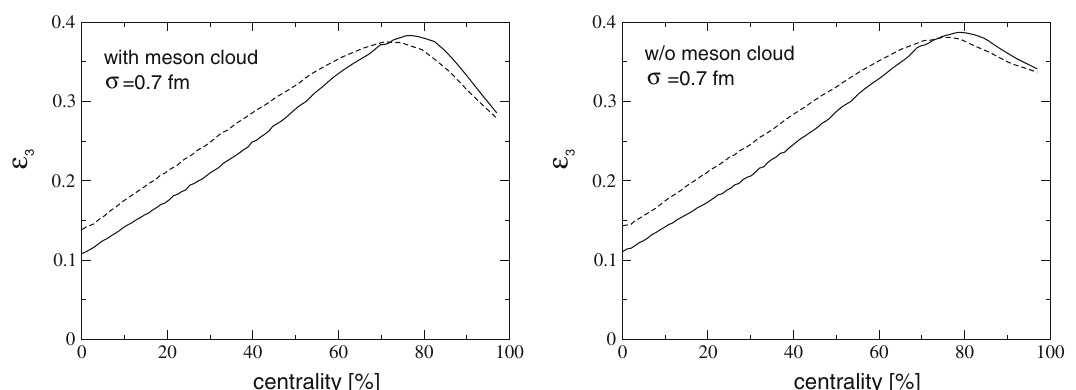
Fig. 4 Same as in Fig. 3 but for σ = 0 . 4 fm